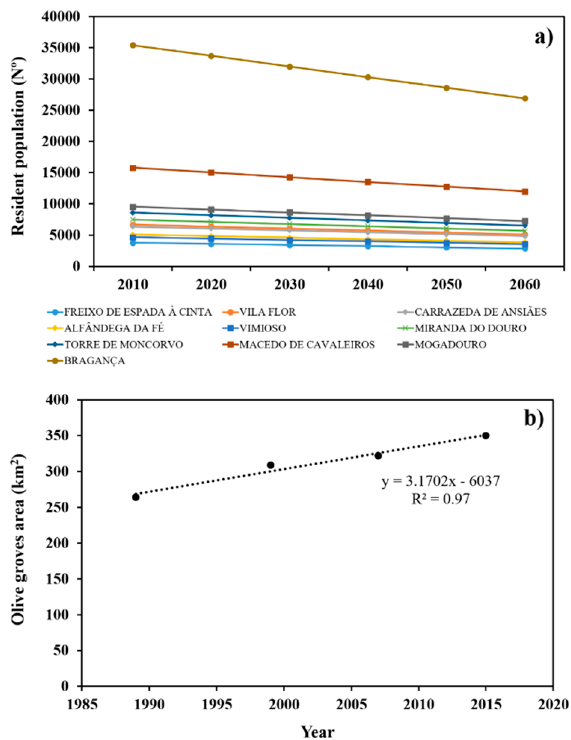
Figure 4. ( a ) Scenario for the resident population’s evolution from 2010 to 2060 for municipalities in the Sabor River basin, and ( b ) Linear regression of the olive grove area between 1989 and 2015. The linear regression was used to make a projection on the olive grove area in 2060. Data on the resident population are from Statistics Portugal [19]. Data on the olive grove area are from the Directorate-General for